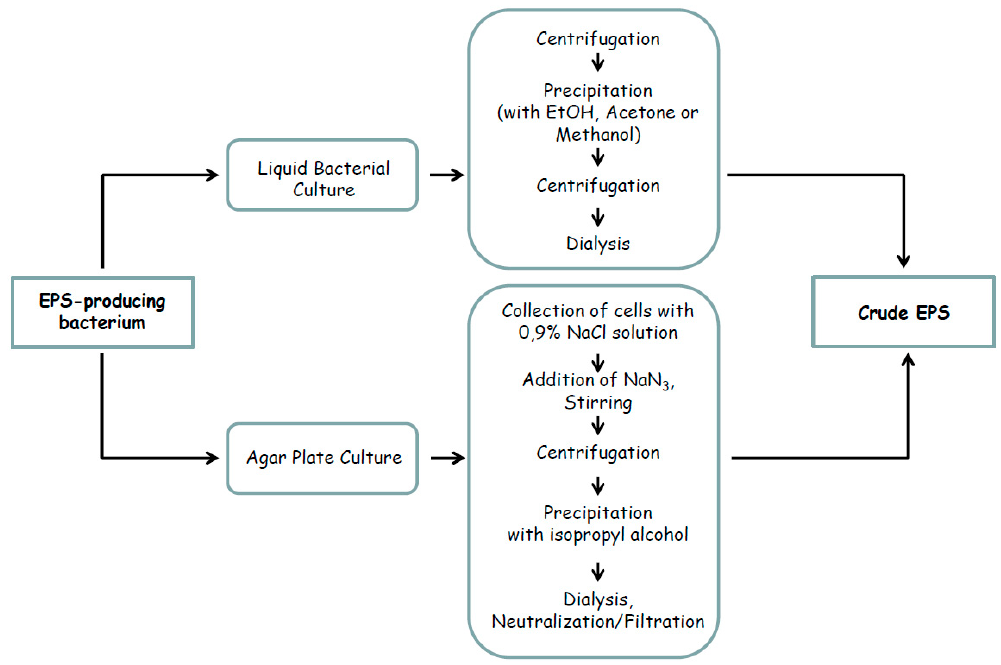
Figure 1. General scheme for EPS isolation [38].